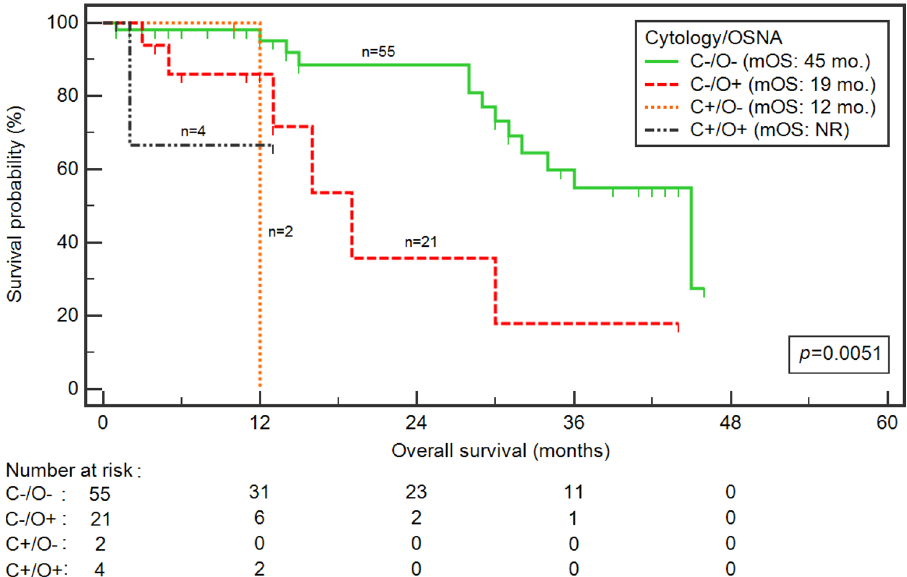
Figure 2. Kaplan–Meier curves representing survival probability depending on combination of cytology and OSNA assay status in patients with advanced GC. C cytology, mo. months, NR not reach, O